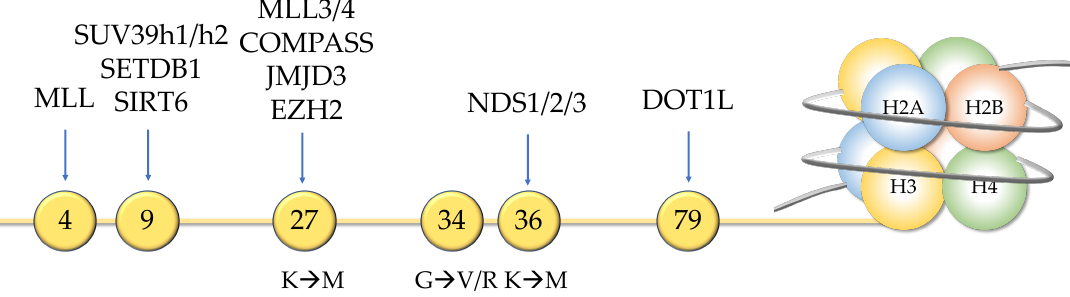
Figure 4. Many writers and erasers of histone H3 are modified in various cancers. In addition, the histone itself can be the target of oncogenic